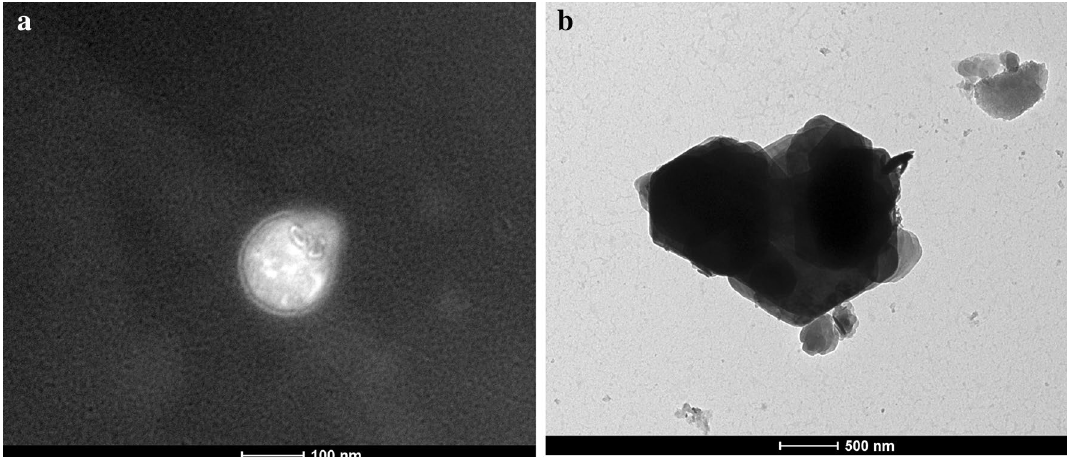
Figure 8. ( a ) TEM image of carbon sphere before loading Zn. ( b ) TEM image of carbon sphere after loading Zn.